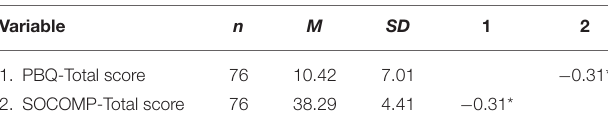
TABLE 5 | Spearman Rank Correlation of bonding impairment assessed 6 weeks after birth with social competencies assessed at 5.5 years. Variable